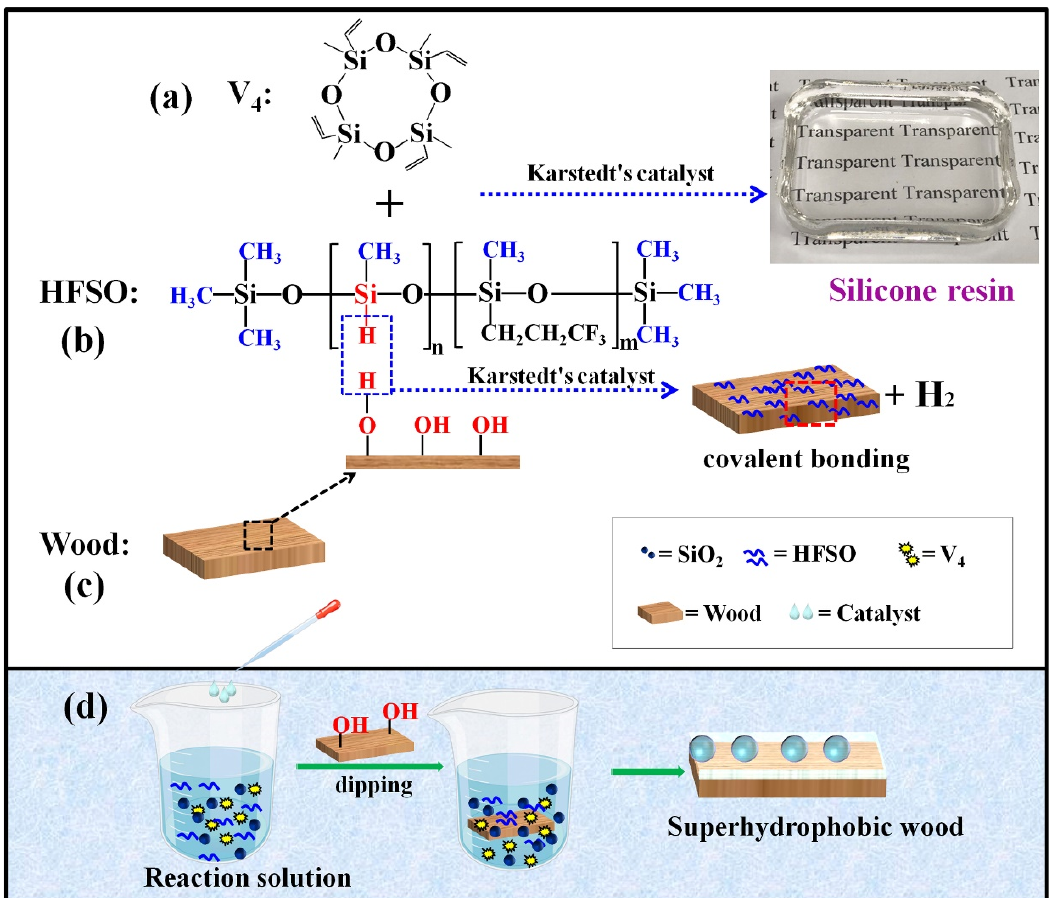
Figure 1. Schematic illustration of the functions and reactions of all components during the con- struction of superhydrophobic silicone resin coatings on wood surfaces: ( a ) V 4 structure; ( b ) HFSO structure; ( c ) Wood; ( d ) Schematic diagram of wood modification.